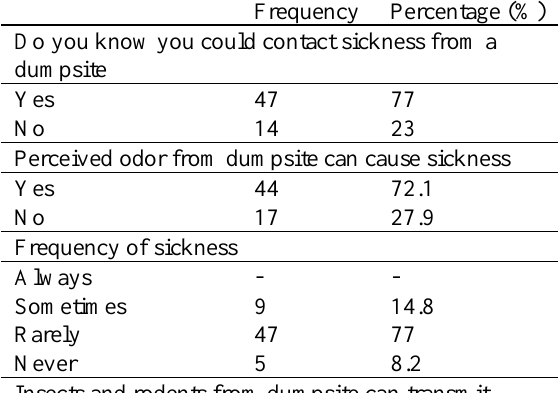
Table 4. Perception of respondents working on dumpsite on hazards